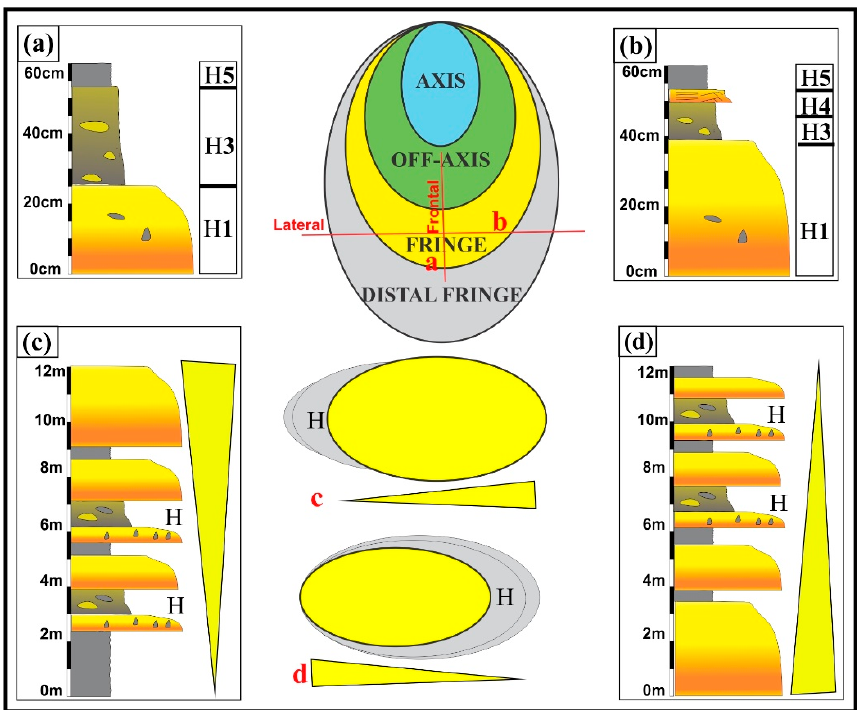
Figure 13. Distribution of hybrid facies. ( a ) Frontal lobes with incomplete hybrid facies. ( b ) clean sand (H1) and muddy sand (H3) facies in lateral lobes. ( c ) Hybrid bed facies in lobe progradation with hybrid beds in the lower part. ( d ) lobe retrogradation with hybrid beds in the upper part of the lobe.